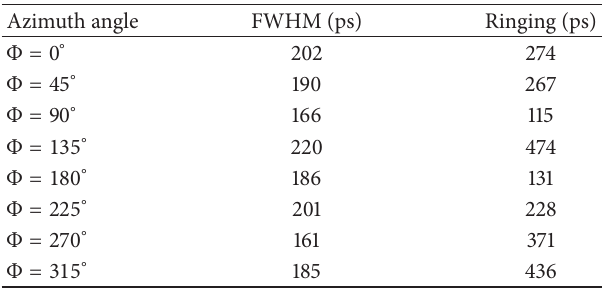
Table1:MeasuredFWHMandringingofantennaimpulseresponse for varying azimuth